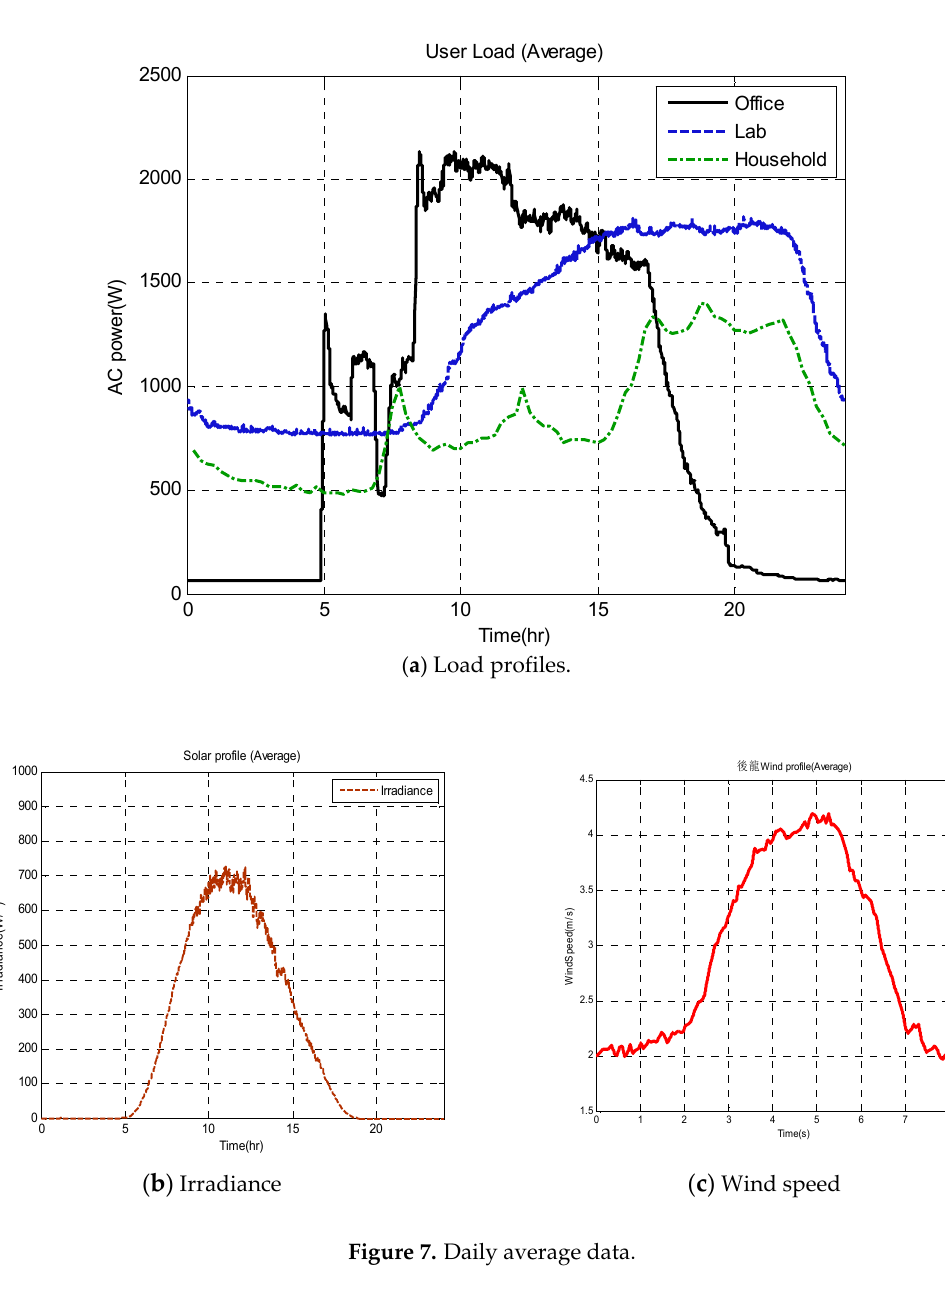
Figure 6. Flow charts of the power management.